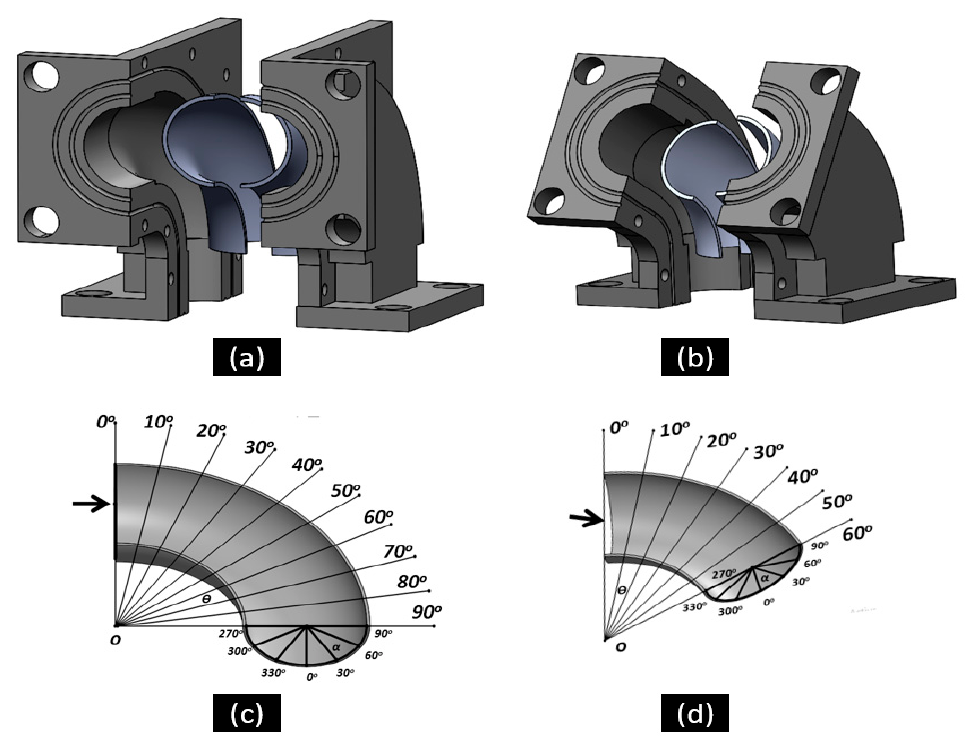
Figure 5. The 90 ◦ ( a ) and 60 ◦ ( b ) elbow test sections used for the erosion–corrosion studies; Figure 5. The 90° ( a ) and 60° ( b ) elbow test sections used for the erosion–corrosion studies; ( c , d ) ( c , d ) definition of the axial definition of the axial angles.